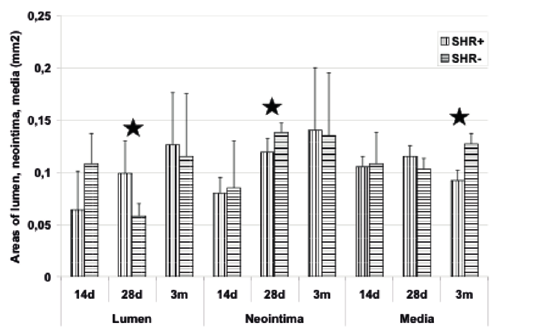
Figure 1. Bar graph demonstrating areas of lumen, neointima and media with time after balloon angioplasty in spontaneously hypertensive rats with (SHR+) and without ACE inhibitor (SHR-). Asterisk= p<0.05.